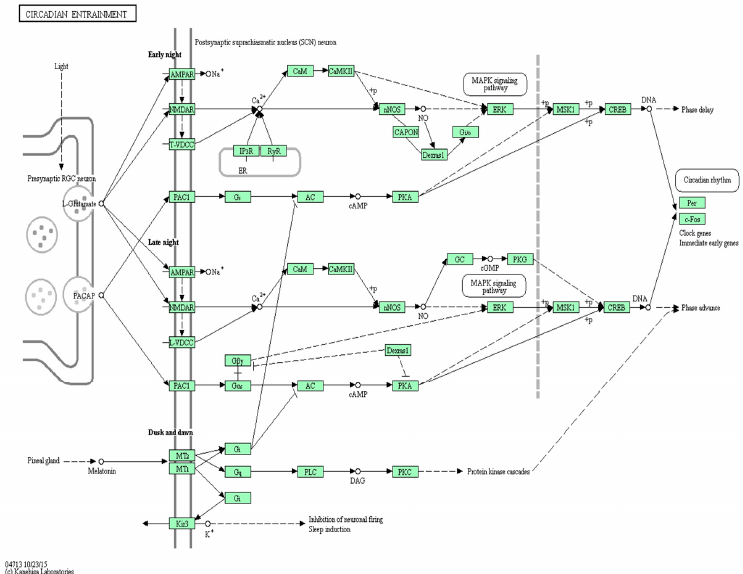
Figure 1. Circadian entrainment is an intrinsic, internal biological clock entrained by exogenous signals, such as endocrine and behavioral rhythms synchronized to environmental cues. The master clock located in the suprachiasmatic nuclei (SCN) of the hypothalamus synchronizes circadian oscillators in peripheral tissues. The main photic input to the suprachiasmatic nuclei comes from the retinal ganglion cells which use glutamate and PACAP, which leads to activation of AMPA and NMDA receptors. The release of glutamate and PACAP triggers the activation of signal transduction cascades including CamKII and nNOS activity, cAMP- and cGMP-dependent protein kinases and mitogen-activated protein kinase (MAPK). Also, melatonin affects non-photic entrainment by inhibiting light-induced phase shifts through inhibition of adenylate cyclase (AC). Additionally, multiple entrainment pathways converge to phosphorylate CREB and to activate CLOCK gene expression [28–31]. Solid and dotted lines indicate direct and indirect relationships, respectively.